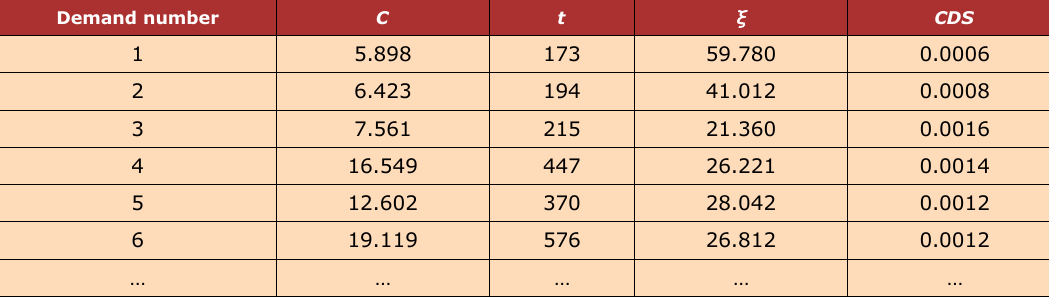
Table 4. Variable changing according to demand meeting number